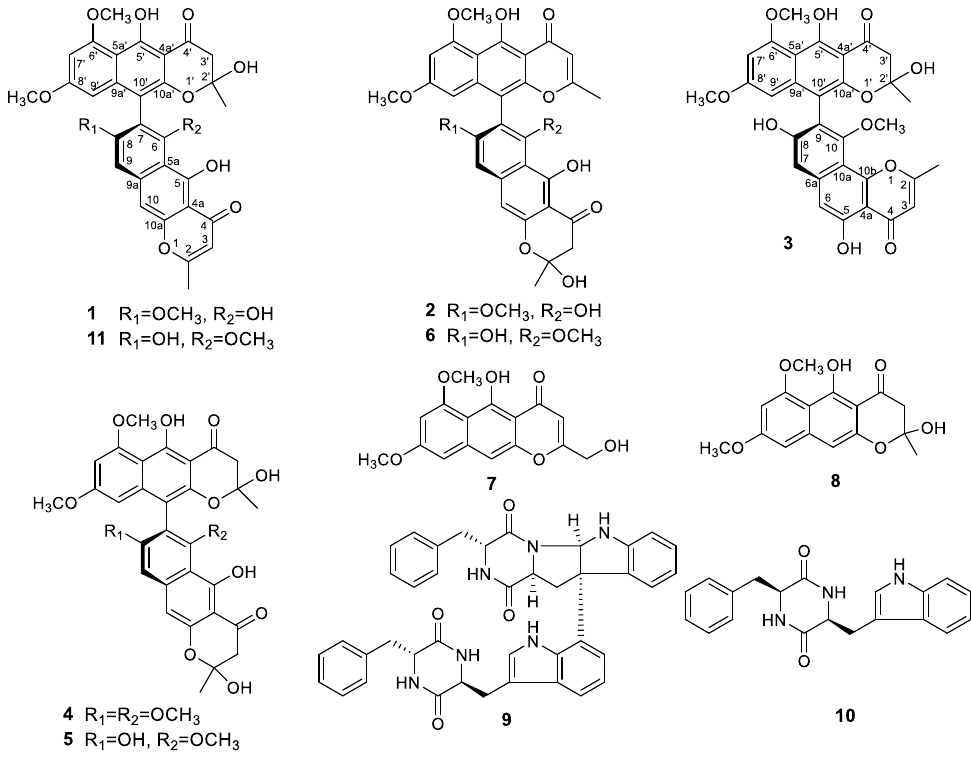
Figure 1. Structures of metabolites isolated from Teratosphaeria sp. AK1128.